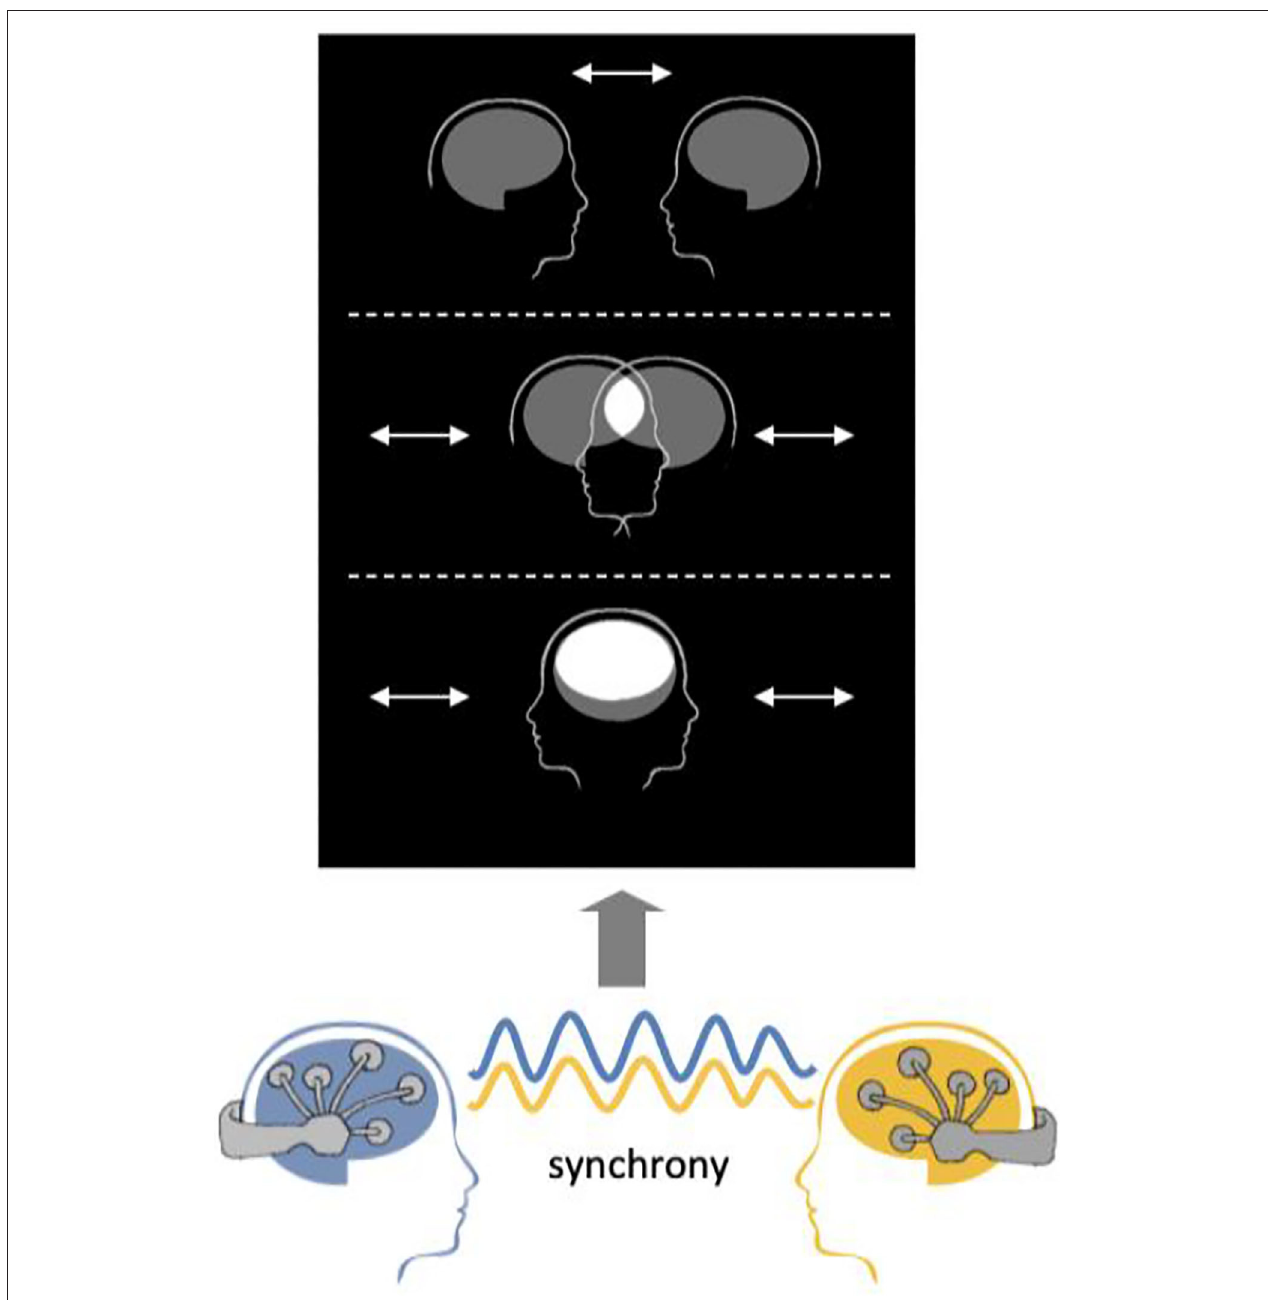
FIGURE 6 | Visualization schematic. Connectivity values are visualized as the distance between the two merging heads using the visualization module.